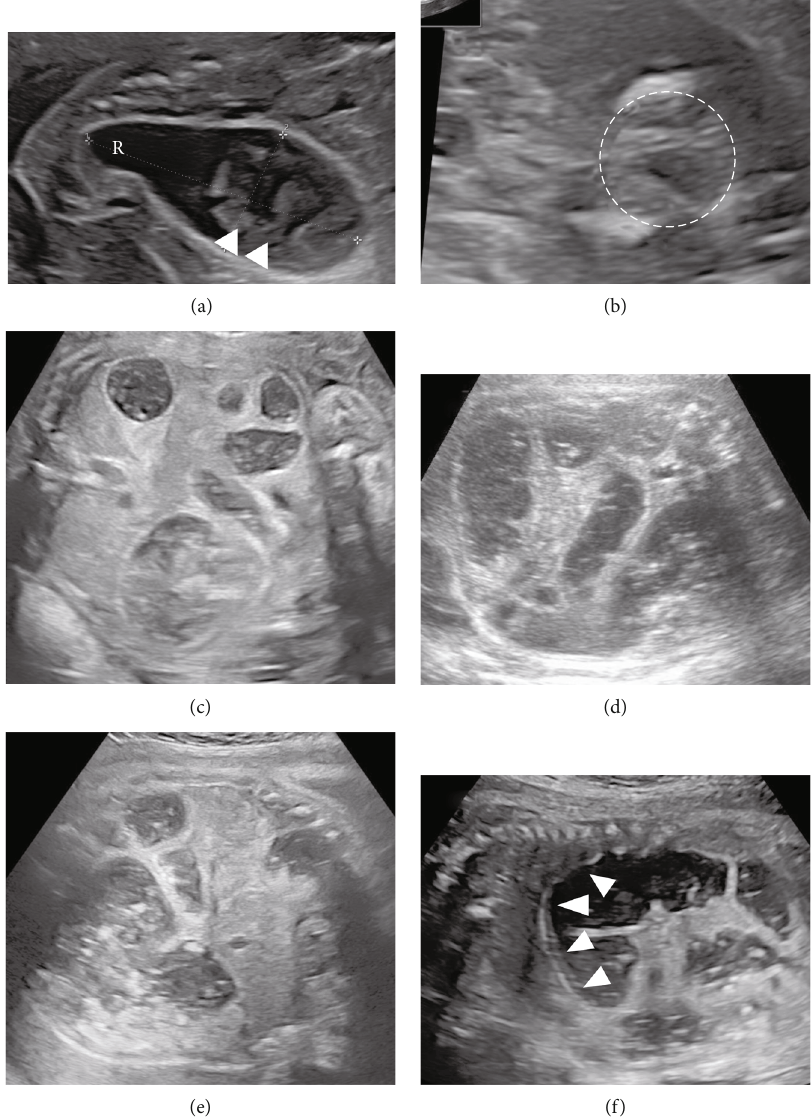
Figure 1: Fetal ultrasonography and the change of fetal bowel. Fetal images. (a) The distal rectal pouch shows dilated bowel with intraluminal calci fi cations (arrowheads) at 20 weeks. R indicates distal rectal pouch. The arrowheads indicate bowel calci fi cations. (b) The echogenic center (dotted circle) is not detectable at 20 weeks, which indicates that anal mucosa is invisible. (c) Fetal bowel dilation at 26 weeks. (d) Fetal bowel dilation at 31 weeks. (e) Fetal bowel dilation at 32 weeks. (f) Thoracic compression by bowel dilation at 31 weeks. The arrowheads indicate the